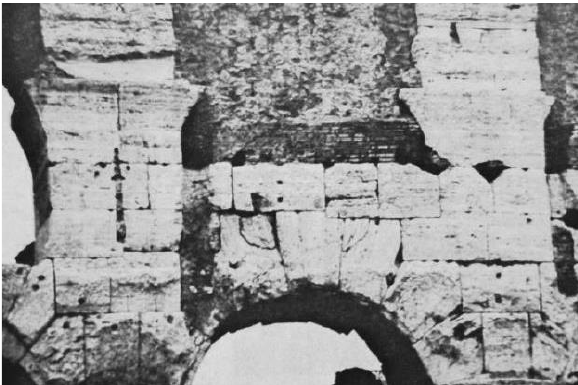
Figure 5. Detail of an arch of the second floor, where the sliding down of the key blocks was observed, as well as different cracks on the travertine blocks.